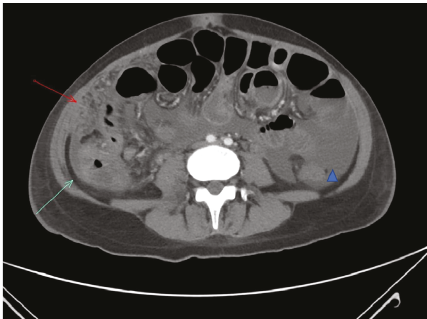
Figure 3: Abdominal findings associated with peritoneal tuber- culosis on CT. Omental thickening (red arrow) and peritoneal thickening (green arrow) are noted along with ascites (blue